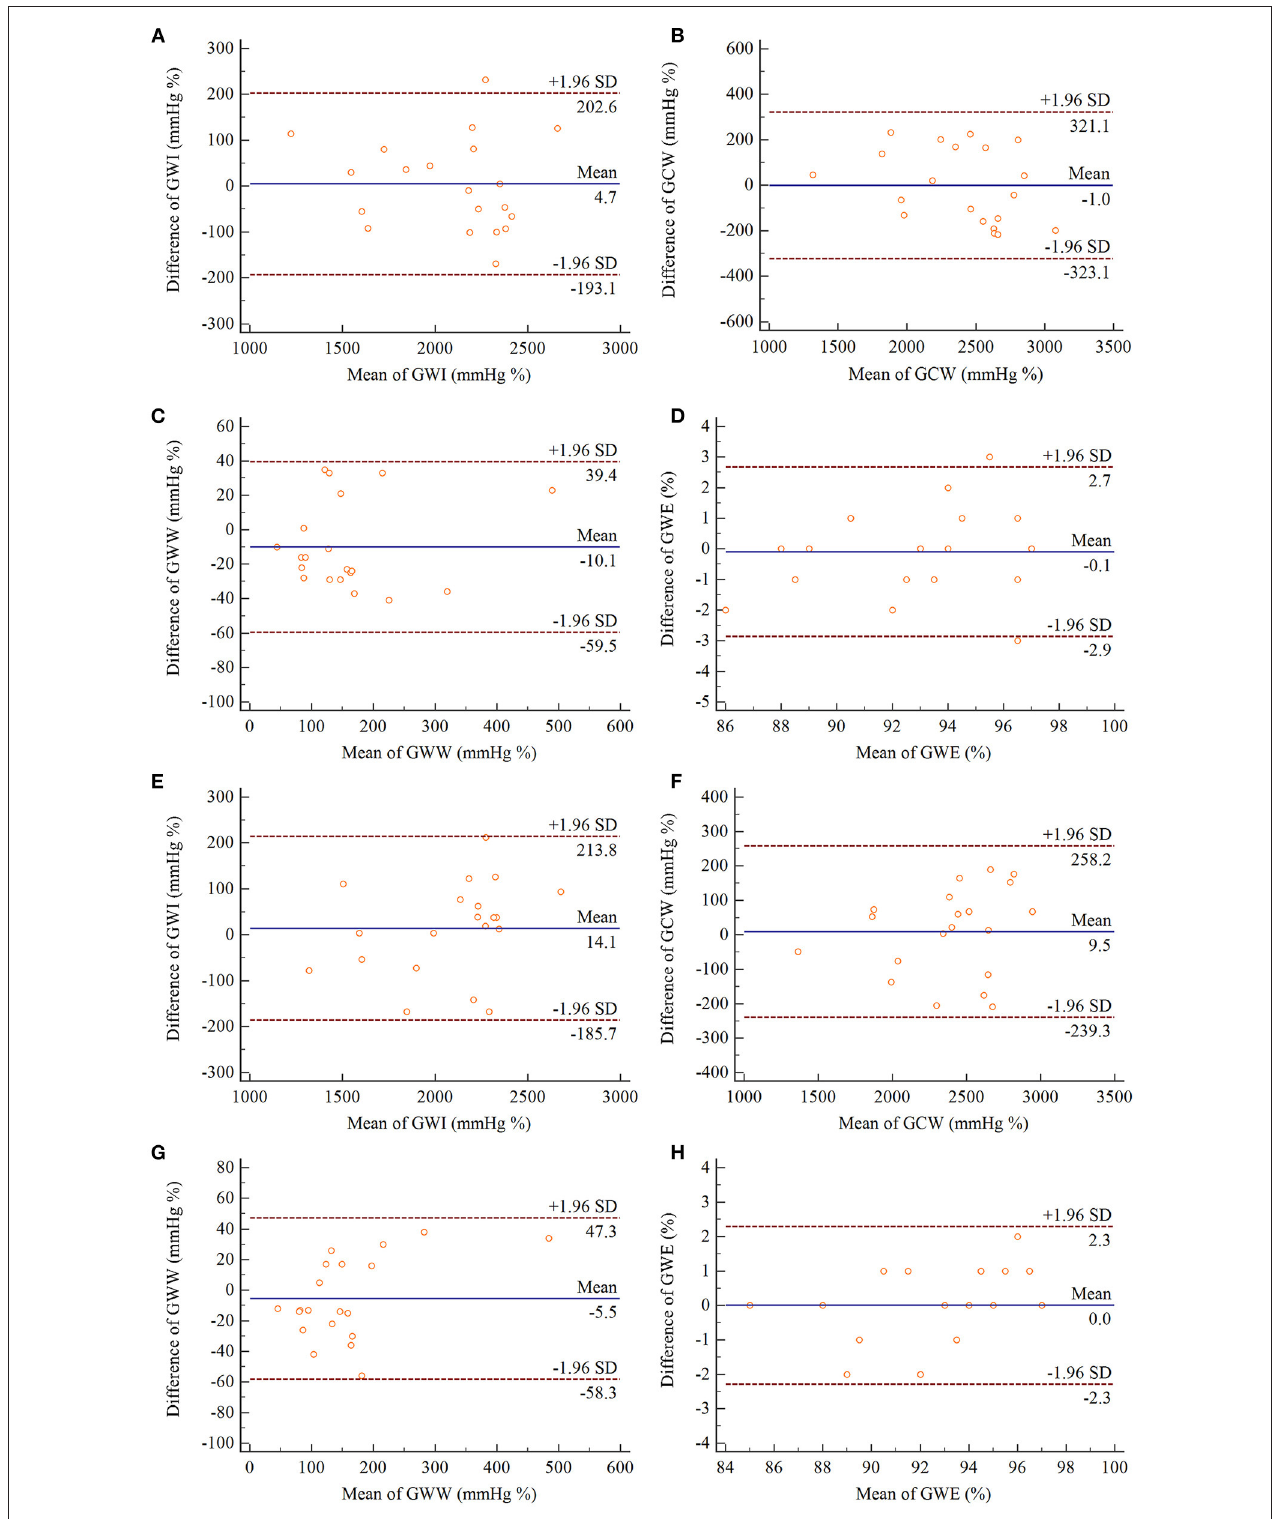
FIGURE 4 | Bland–Altman analyses of intra-observer (A–D) and inter-observer (E–H) reproducibility for measurements of GWI, GCW, GWW, GWE. In each panel, the solid line represents mean difference, and the broken lines represent the 95% limits of agreement. GWI, global work index; GCW, global constructive work; GWW, global waste work; GWE, global work